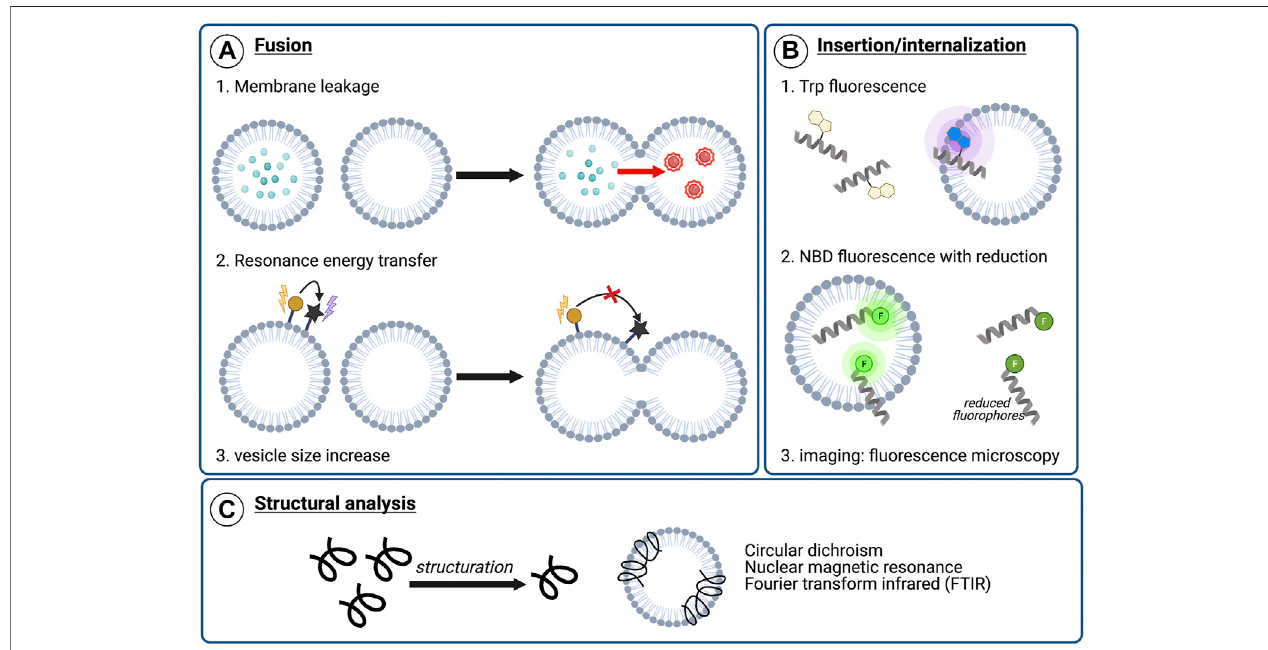
FIGURE4| Examplesofanalyticaltechniquestocharacterizepeptide ’ smembranotropicproperties. (A) Fusogenicproperties:1)Membraneleakageexperiments. After pore formation upon peptide addition, dilution ofthe self-quenching dye from labeled vesicles tounlabeled vesicles results in fl uorescence increase, 2) Lipid mixing withFRET.Theincreasingdistancebetweentwo fl uorophorescomposingaFRETsystemuponlipidmixingcanbevisualizedbymonitoringtheenergytransferef fi ciency decrease,3)Lipidmixingcanalsobehighlightedbydynamic lightscattering (DLS)monitoringthevesiclesizeincrease, (B) Insertionorinternalizationpropensity: 1) Peptide insertion can be monitored by following Trp fl uorescence. Upon membrane insertion, the hydrophobic environment around Trp results in a blue-shift in fl uorescence, 2) NBD/sodium dithionite experiments. NBD-labeled sequences are incubated with liposomes and a reducing agent, sodium dithionite, is added. After reduction, the remaining fl uorescence indicate the degree of membrane insertion/internalization, 3) Imaging experiments using fl uorescence microscopy, such as confocal or total internal re fl ection fl uorescent (TIRF) microscopy, with labeled peptide and liposomes or cells (C) Structural characterization in contact with model or cellular membranes to visualize conformational changes upon membrane